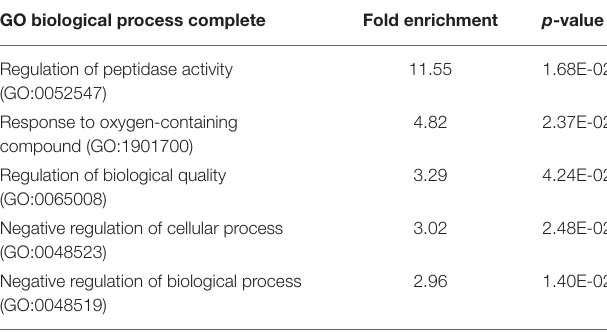
TABLE 4 | Comparison of ns-Zr15 vs ns-Zr25 with respect to biological